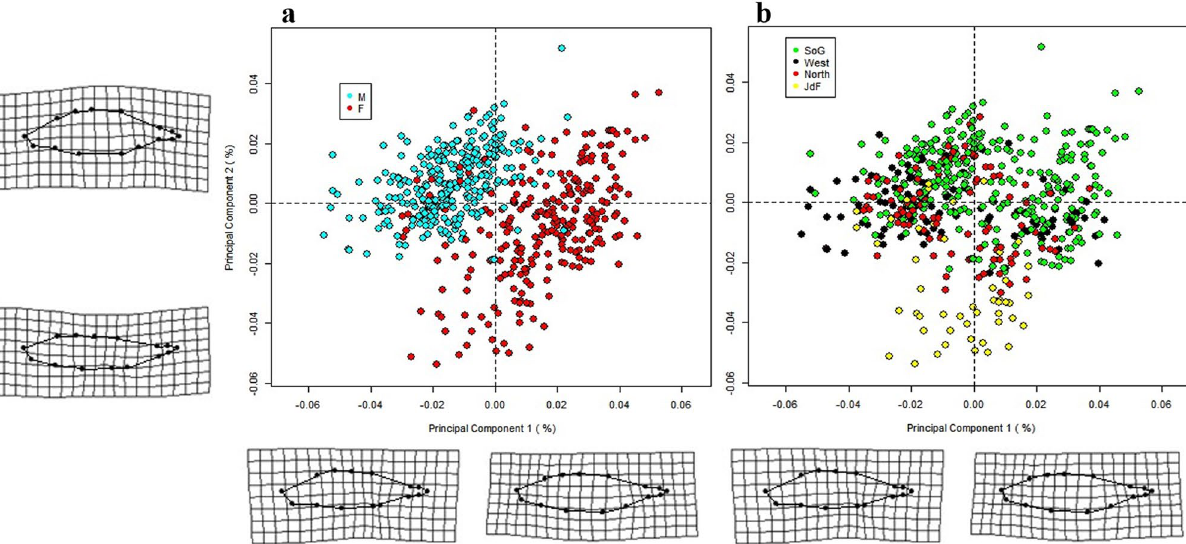
Figure 6. Principal Component Analysis (PCA) of body shape. The body shape for each specimen was obtained from a set of fifteen anatomical landmarks, shown in the methods section (Fig. 7). The landmarks were converted into 30 shape variables by way of a Generalized Procrustes Analysis (GPA). These variables were used to carry out the PCA. The body shape variation is illustrated with the four deformation grids, which represent the difference between the specimen on each end of each shape axis (PC1 and PC2). The effects of body size were removed from this analysis. ( a ) Each data point represents data from a female stickleback (red circles) and male stickleback (light blue circles). ( b ) Each data point represents data from the four oceanographic regions that surround Vancouver Island, BC: Strait of Georgia (green), west coast Vancouver Island (black), north coast Vancouver Island (red), and the Juan de Fuca Strait